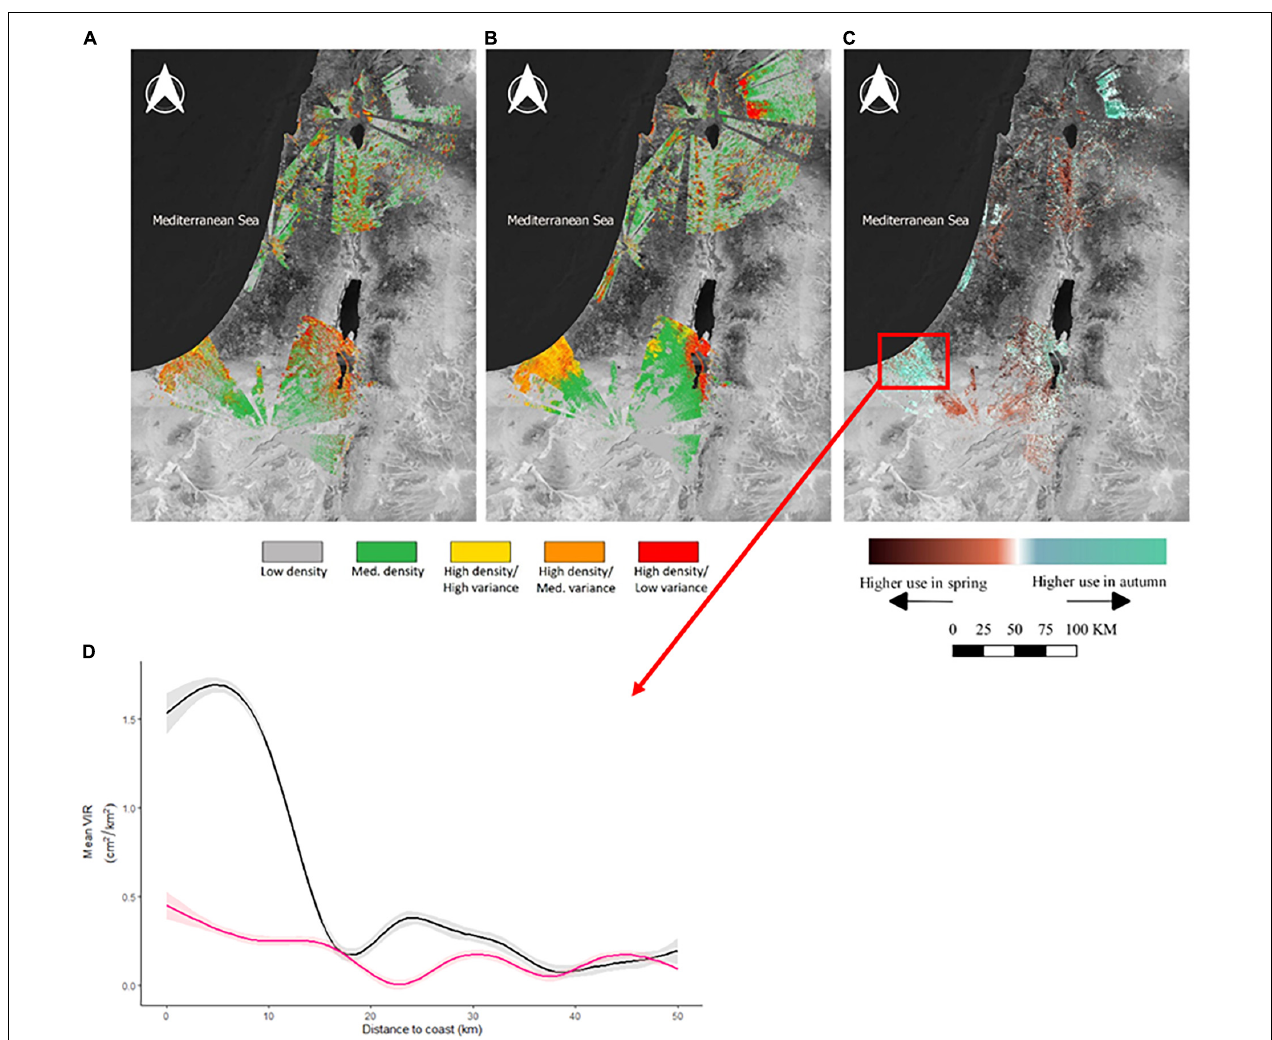
FIGURE 2 | Spatial mapping of bird stopover densities classified by seasonal mean and coefficient of variation during (A) spring and (B) autumn. Classes are divided by seasonal mean stopover density as “low density” ( < 50th percentile), “medium density” (50th–85th percentile), and “high density” ( ≥ 85th percentile), and high density areas are further classified by the coefficient of variation as “high variance” ( > 75th percentile), “medium variance” (25th–75th percentile), and “low variance” ( ≤ 25th percentile). (C) Seasonal differences in mean reflectivity between the autumn and the spring. (D) Example of the change in mean vertically integrated bird reflectivity (VIR; cm 2 /km 2 ) by distance to coast from Ramon radar in autumn (black line and a gray error area) and in spring (dark pink line and light pink error